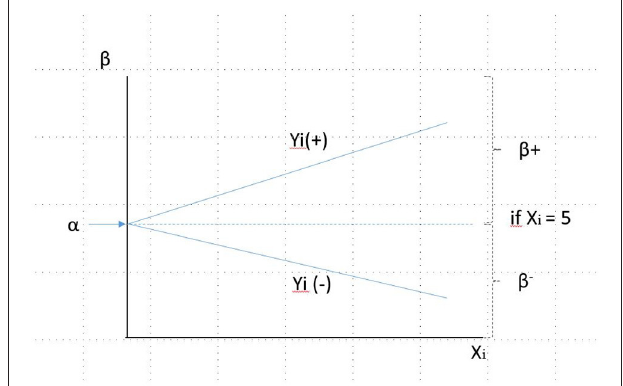
FIGURE 8 | Explanatory regression of the emotional value. Source: own compilation.